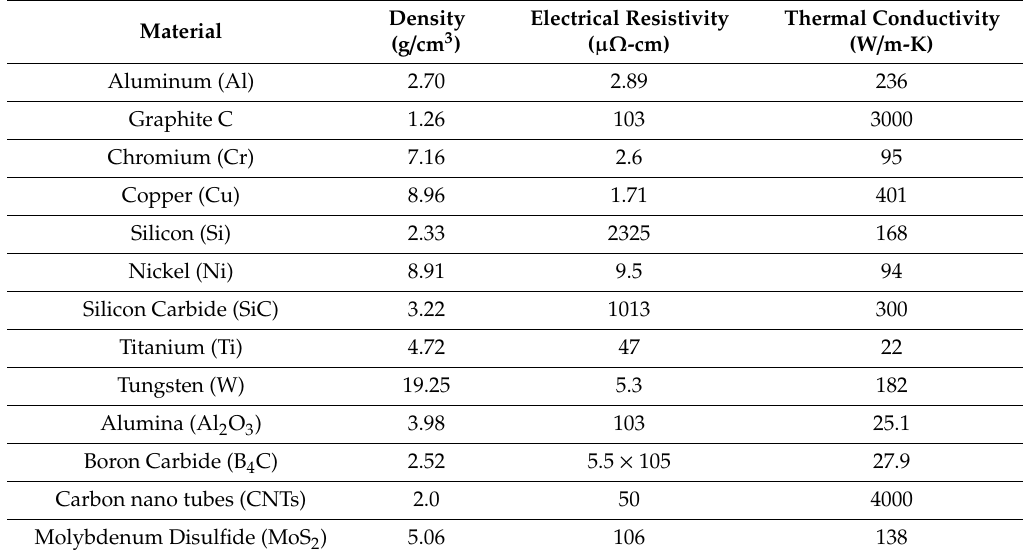
Table 2. Commonly used powders in powder-mixed EDM (PMEDM) and their physical properties